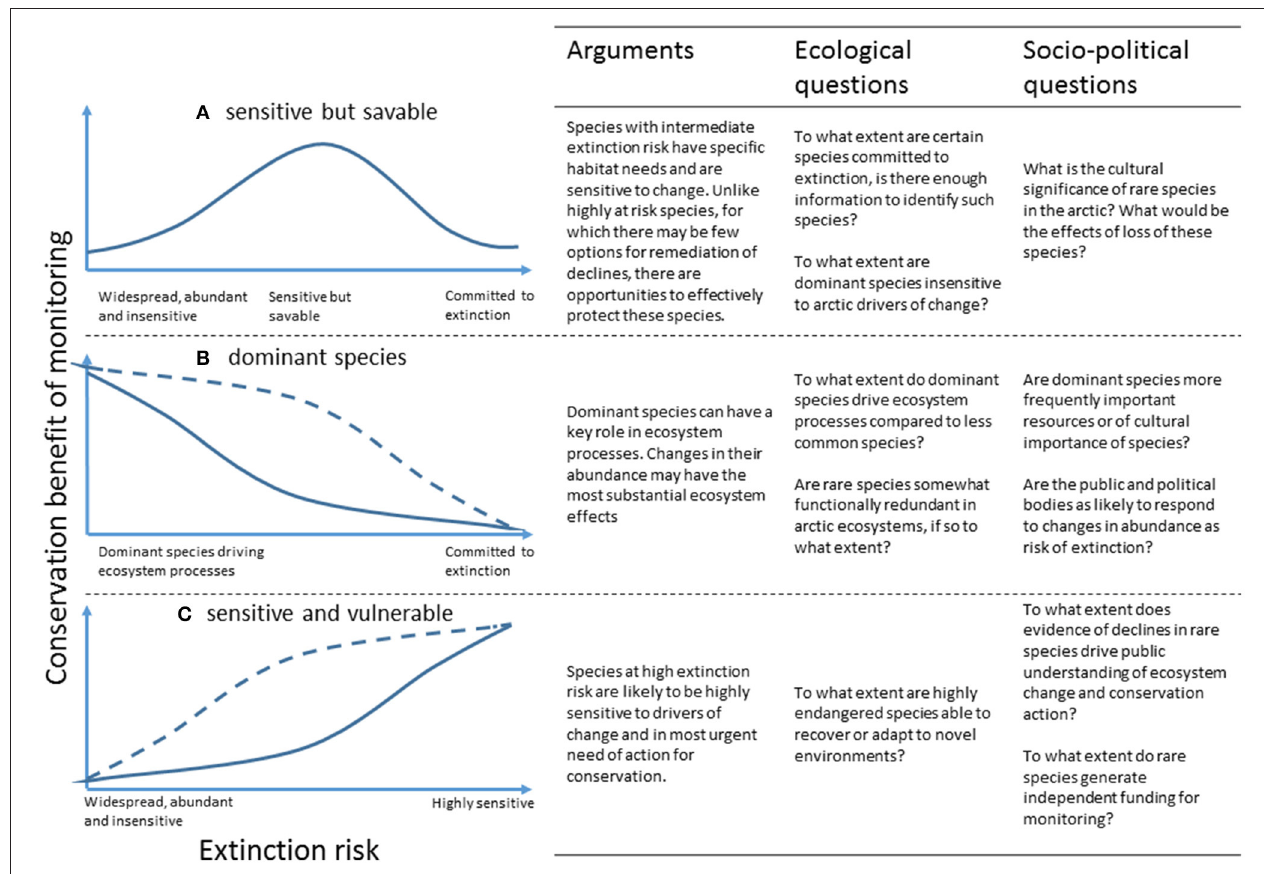
FIGURE 2 | Three possible scenarios for the relationship between extinction risk and conservation benefit of monitoring: (A) where monitoring both high and low extinction risk species provides fewer conservation benefits, (B) where greatest benefits derive from monitoring dominant species, and (C) where greatest benefits are generated from high extinction risk species. Both (A,B) involve the concept of triage. Explanations for each approach are given under arguments in the associated table and ecological and socioecological questions pertinent to each model are given. Solid and dashed lines represent alternative function forms within the same broad concept. Note that questions can also have overlapping applicability between multiple